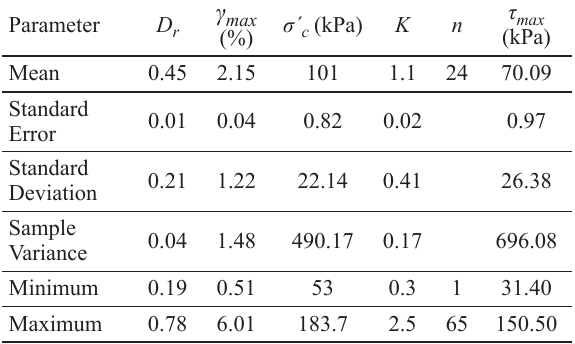
Table 1. The variables used in model development